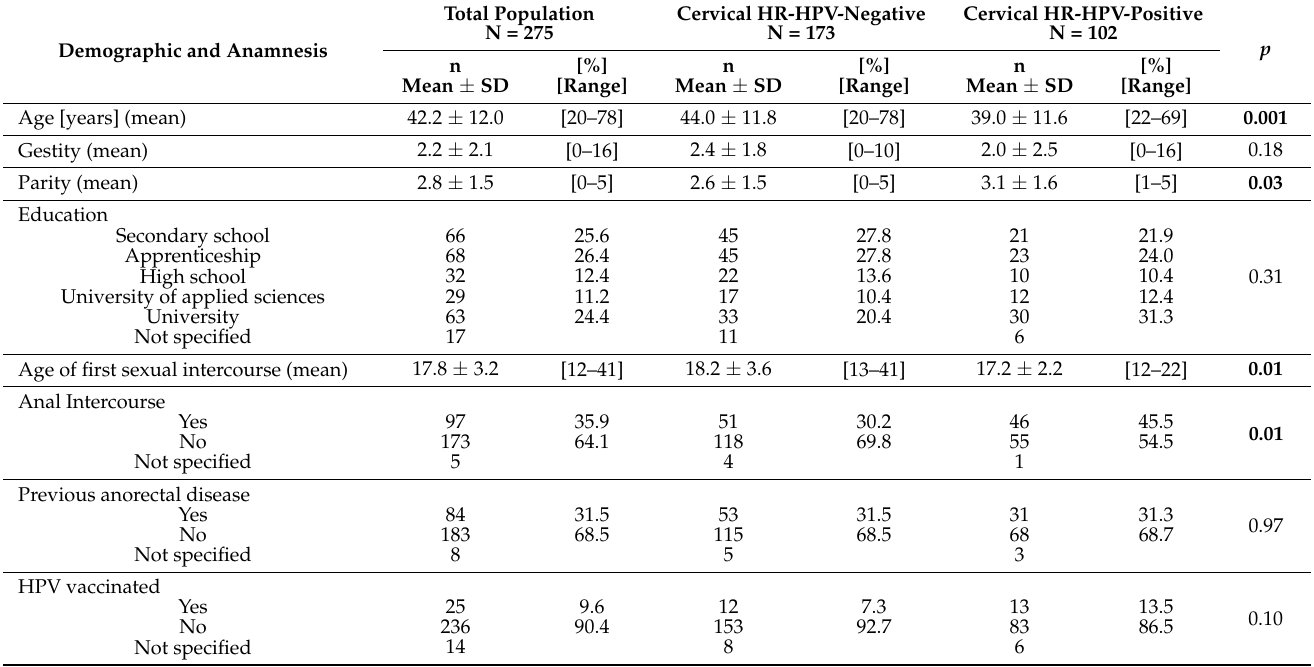
Table 1. Demographics of total population, patients without cervical HR-HPV, and patients with cervical